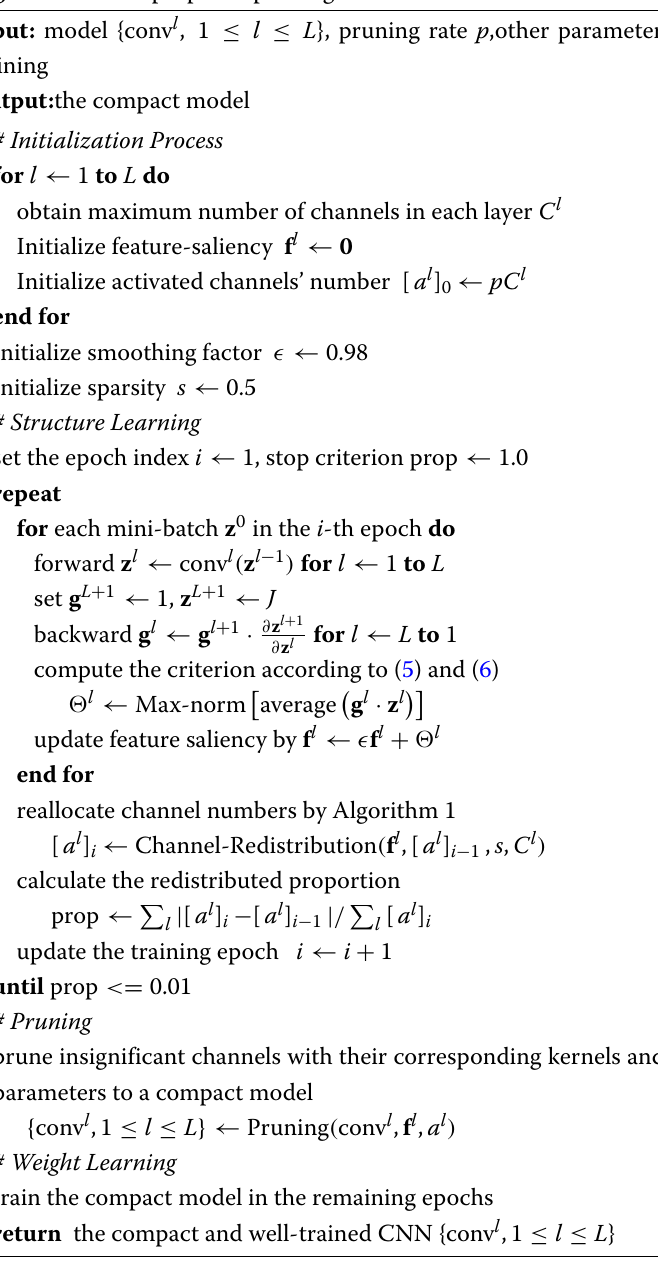
Algorithm 2 The proposed pruning